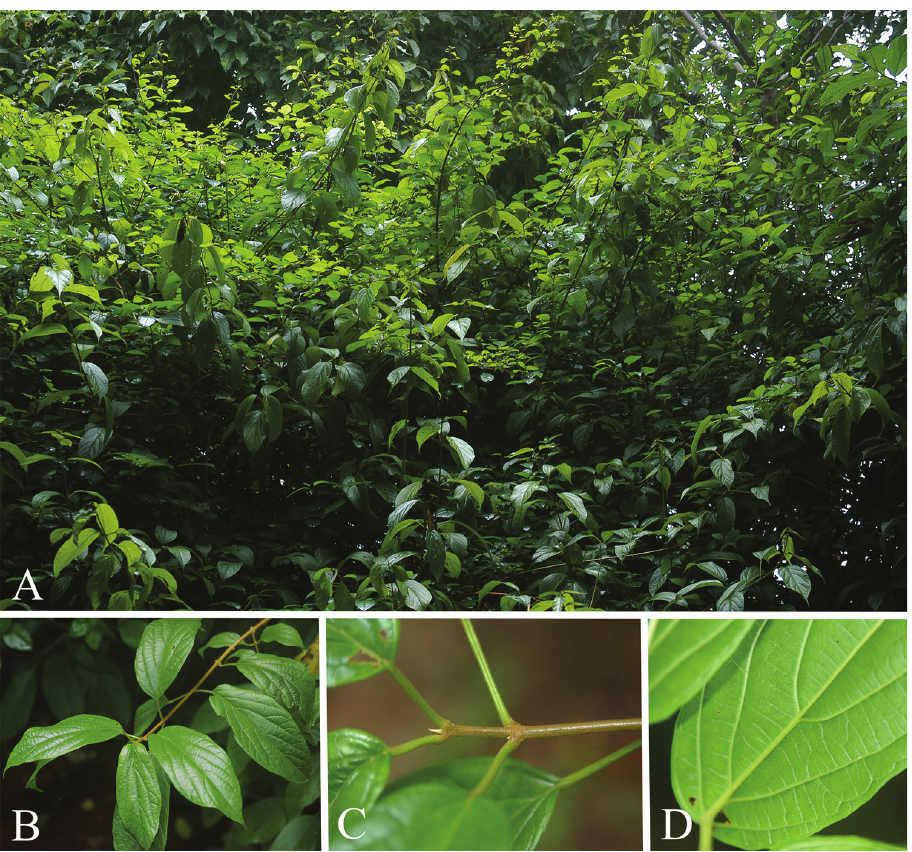
Figure 1. Premna bhamoensis Y. T. Tan & B. Li, sp. nov. A habit B a branchlet with ovate-oblong to elliptic leaves C branchlet and petioles covered by dense brownish pubescences D abaxial surface of leaf